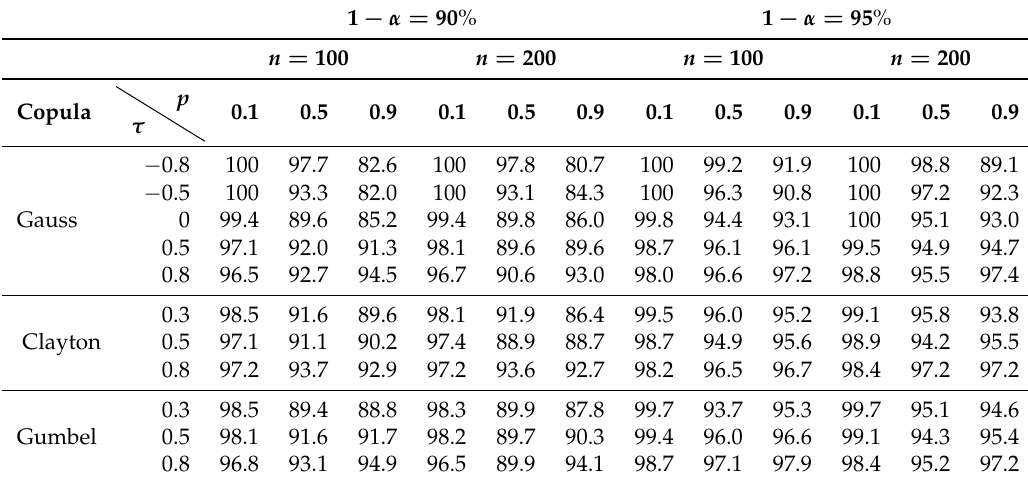
Table 1. Simulation results for the extended Mammen and Polonik [14] approach. The overall coverage probabilities are reasonable.